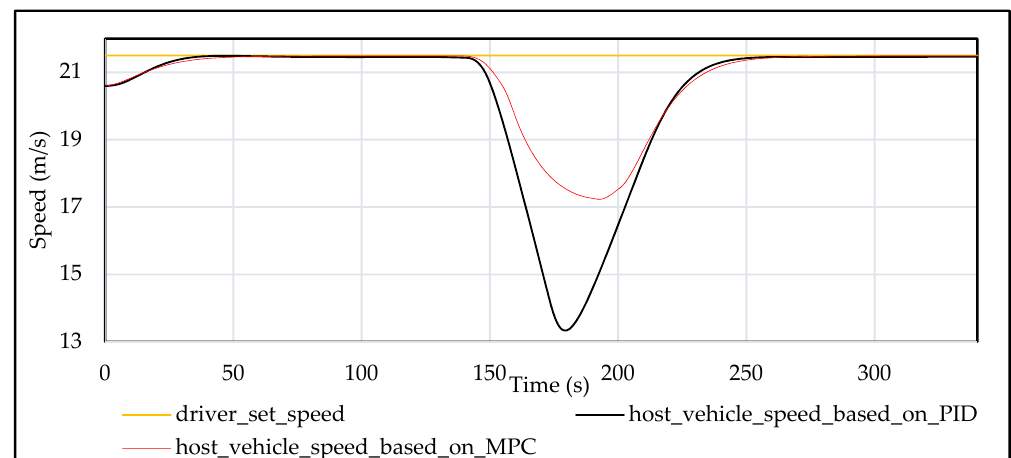
Figure 12. Speed response in scenario 2 .